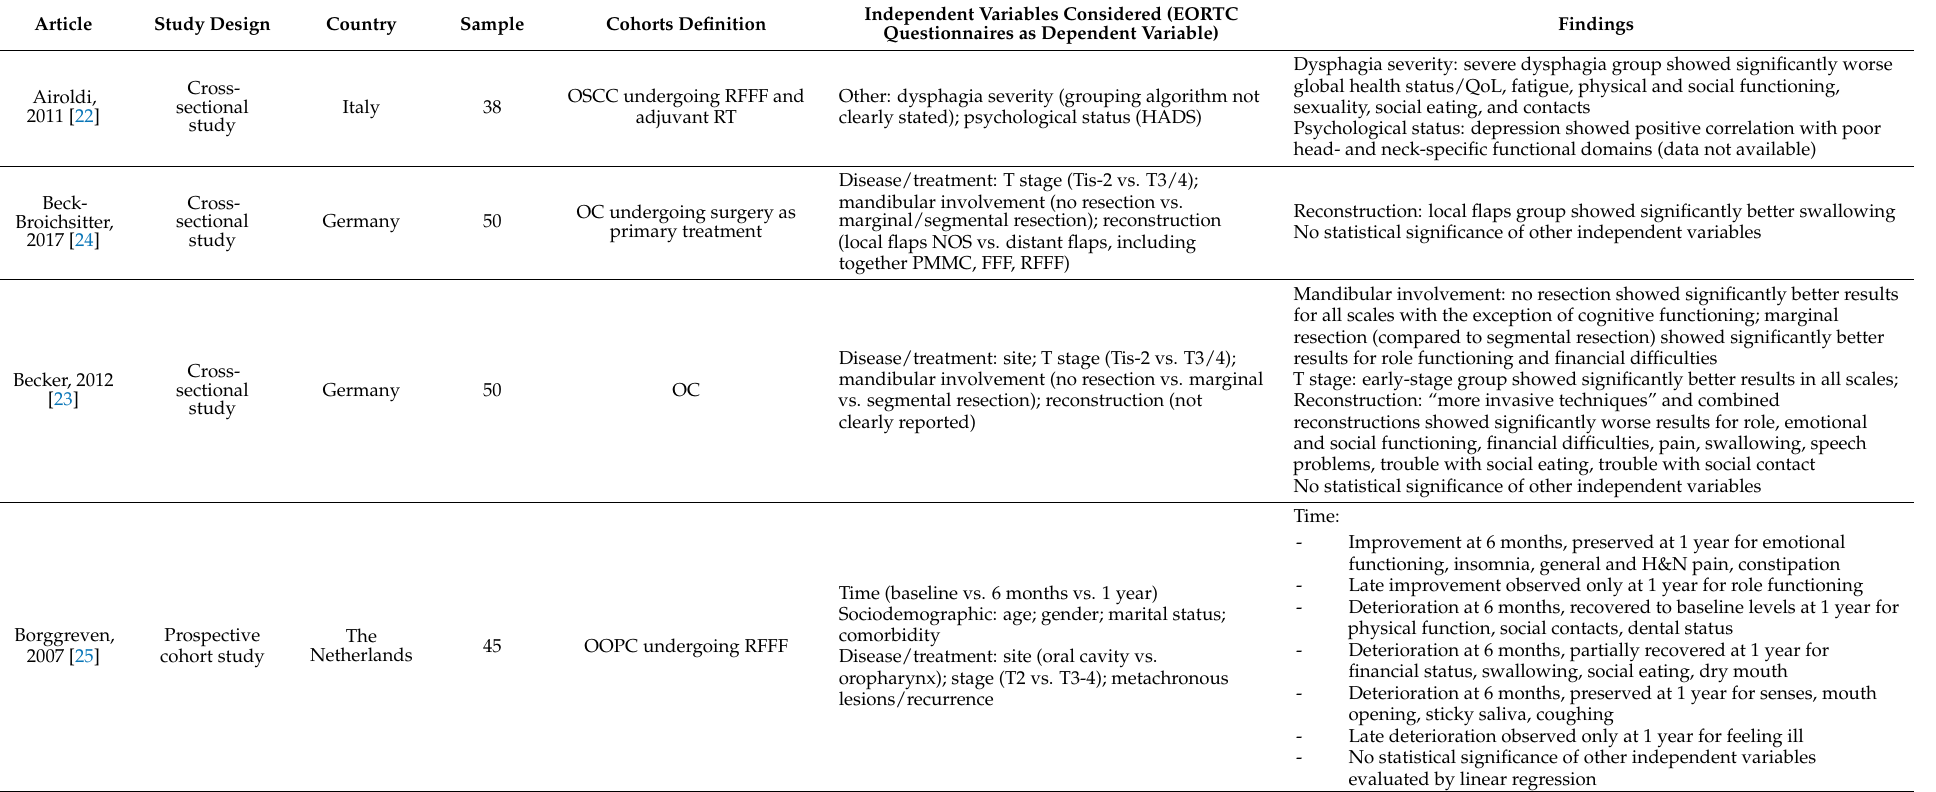
Table 2. Study design and independent variables considered for data stratification and findings. Legend to Table 2: ACE-27 = Adult Comorbidity Evaluation 27 score; ADM = acellular dermal matrix; BAMM = buccinator myomucosal flap; BOT = base of tongue; CRT = chemoradiotherapy; CT = chemotherapy; DCIA = deep circumflex iliac artery flap; FFF = free fibula flap; FOM = floor of the mouth; G8 = Geriatric 8 screening tool; HADS = Hospital Anxiety and Depression Scale; HNC = head and neck cancer; KFI = Kaplan–Feinstein index; MRND = modified radical neck dissection; ND = neck dissection; NOS = not otherwise specified; OC = oral cavity; OCC = oral cavity cancer; OP = oropharynx; OOP = oral cavity and oropharynx; OOPC = oral/oropharyngeal cancer; ORFFF = osteofasciocutaneous radial forearm free flap; OSCC = oral squamous cell carcinoma; PMMC = pectoralis major myocutaneous flap; RFFF = radial forearm free flap; RT = radiotherapy; SCAIF = supraclavicular artery island flap; SCC = squamous cell carcinoma; SND = selective neck dissection; STSG = split thickness skin